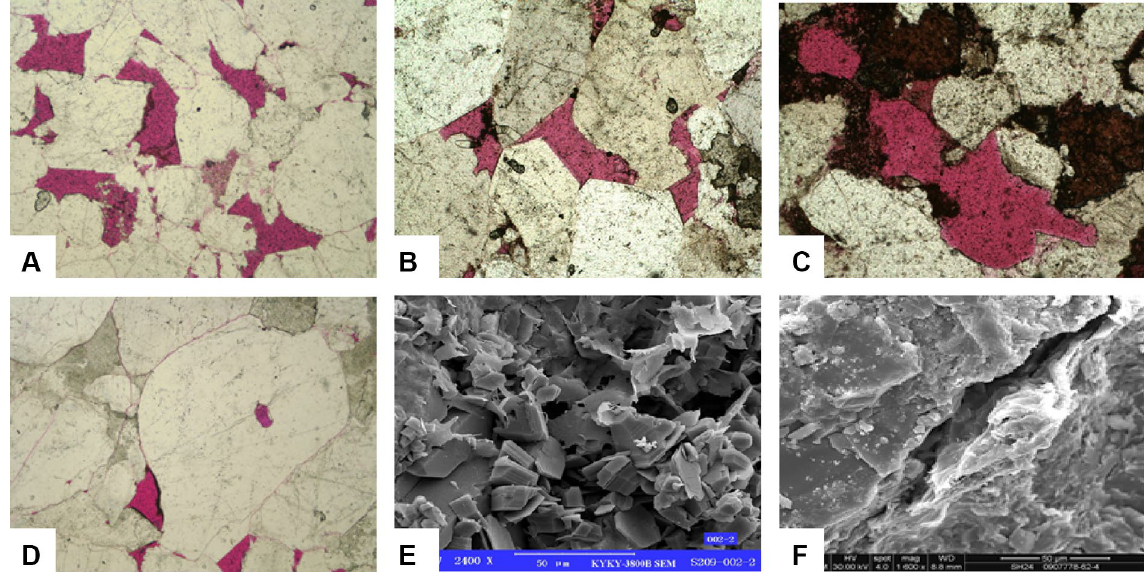
Fig. 5 Microscopic characteristics of the sandstone reservoirs. ( A : residual intergranular pore, 2431.23 m; B : residual intergranular pore, 2727.07 m; C : intergranular dissolved pores, 2631.23 m; D : dissolved